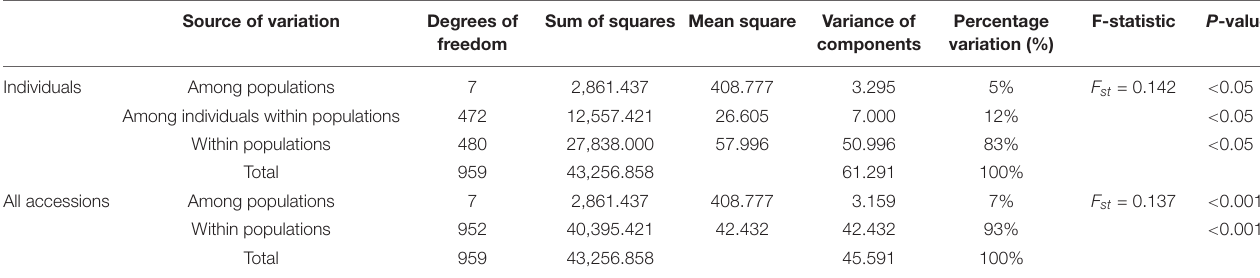
TABLE 7 | Analysis of molecular variance (AMOVA) for 480 accessions of Psathyrostachys juncea